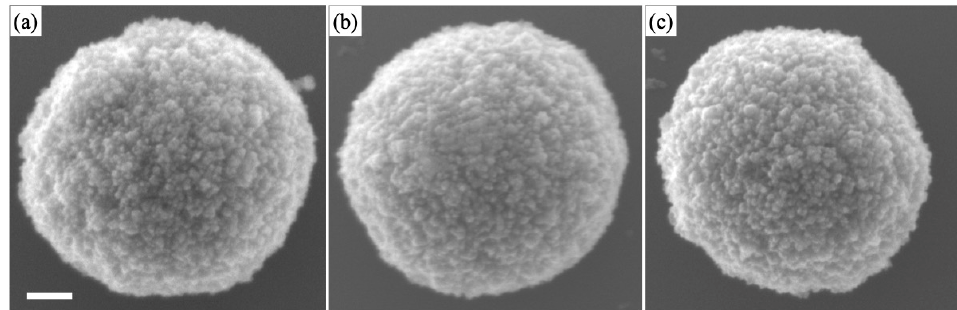
Figure 4. SEM images of Cu-doped TiO 2 particles with different dopant concentrations: ( a ) 0.1, ( b ) 1, and ( c ) 10 mM. Scale bar indicates 200 nm.